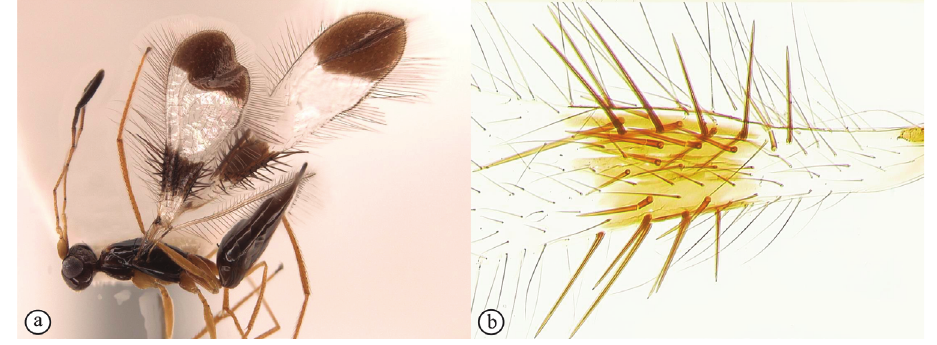
– Ovipositor normal, not extending forward underneath the body (a); modi-